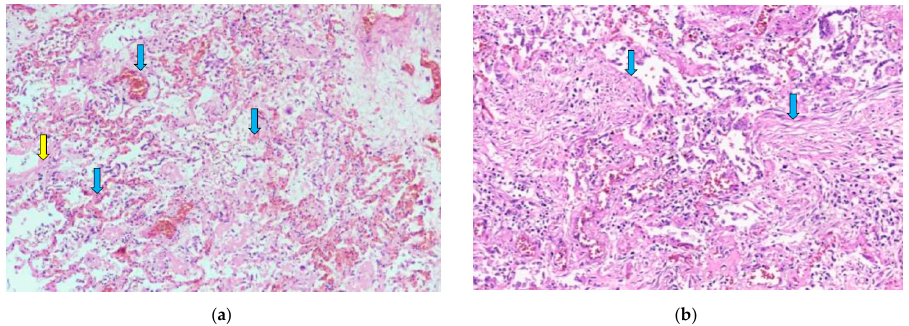
Figure 1. ( a ) Diffuse alveolar damage, exudative phase. Hyaline membranes (yellow arrow) and a sparse inflammatory infiltrate with mostly macrophages and lymphocytes are seen. Capillary thromboses (blue arrows) and some hemorrhaging are also visible. H & E stain; magnification ×40. ( b ) Diffuse alveolar damage, proliferative phase. Alveolar walls are thickened, and fibrous polyps can be seen in the lumen of alveoli (blue arrows). H & E stain; magnification ×100.